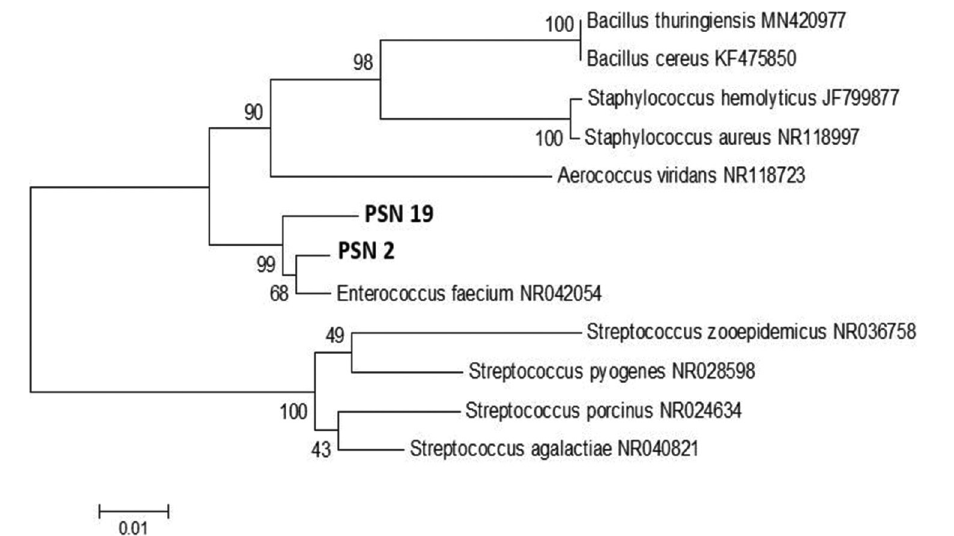
Figure-2: The phylogenetic tree of PSN 2 and PSN 19 Gram-positive β hemolytic isolated from nasal of pig based on 16S ribosomal RNA gene sequences. PSN=Punggul Swab